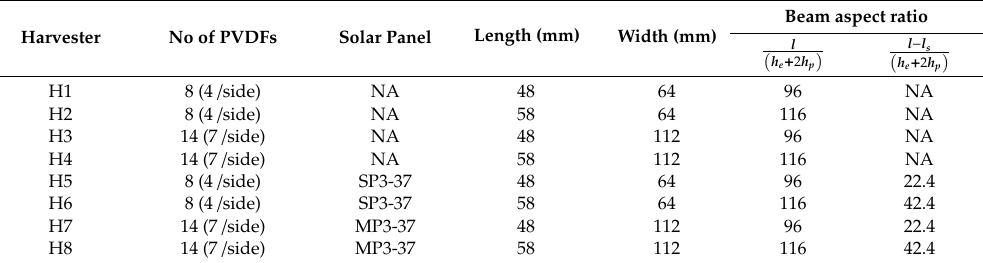
Figure 1. The configuration of the harvesters considered in this study: ( a ) and ( b) schematics of the harvester construction; ( c ) schematic representation of the custom-made mounting system to connect the harvester to the shaker; ( d ) four harvesters realized without incorporating solar panels; ( e ) four harvesters with solar panels. Table 1. Geometric characteristics of the harvesters considered in this